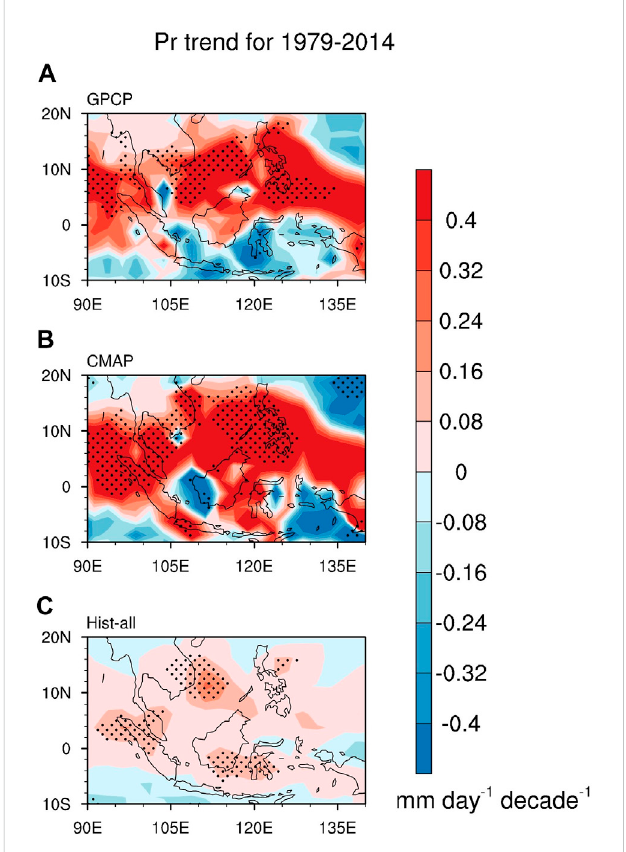
FIGURE 2 Spatial distribution of winter precipitation trends [shading, shading interval (SI) = .08 mm day − 1 decade − 1 ] from 1979 to 2014 over Southeast Asia in (A) GPCP, (B) CMAP, and (C) Hist-all MME, respectively. Values exceeding the 90% con fi dence levels based on the two-tailed Student ’ s t -test are drawn with black